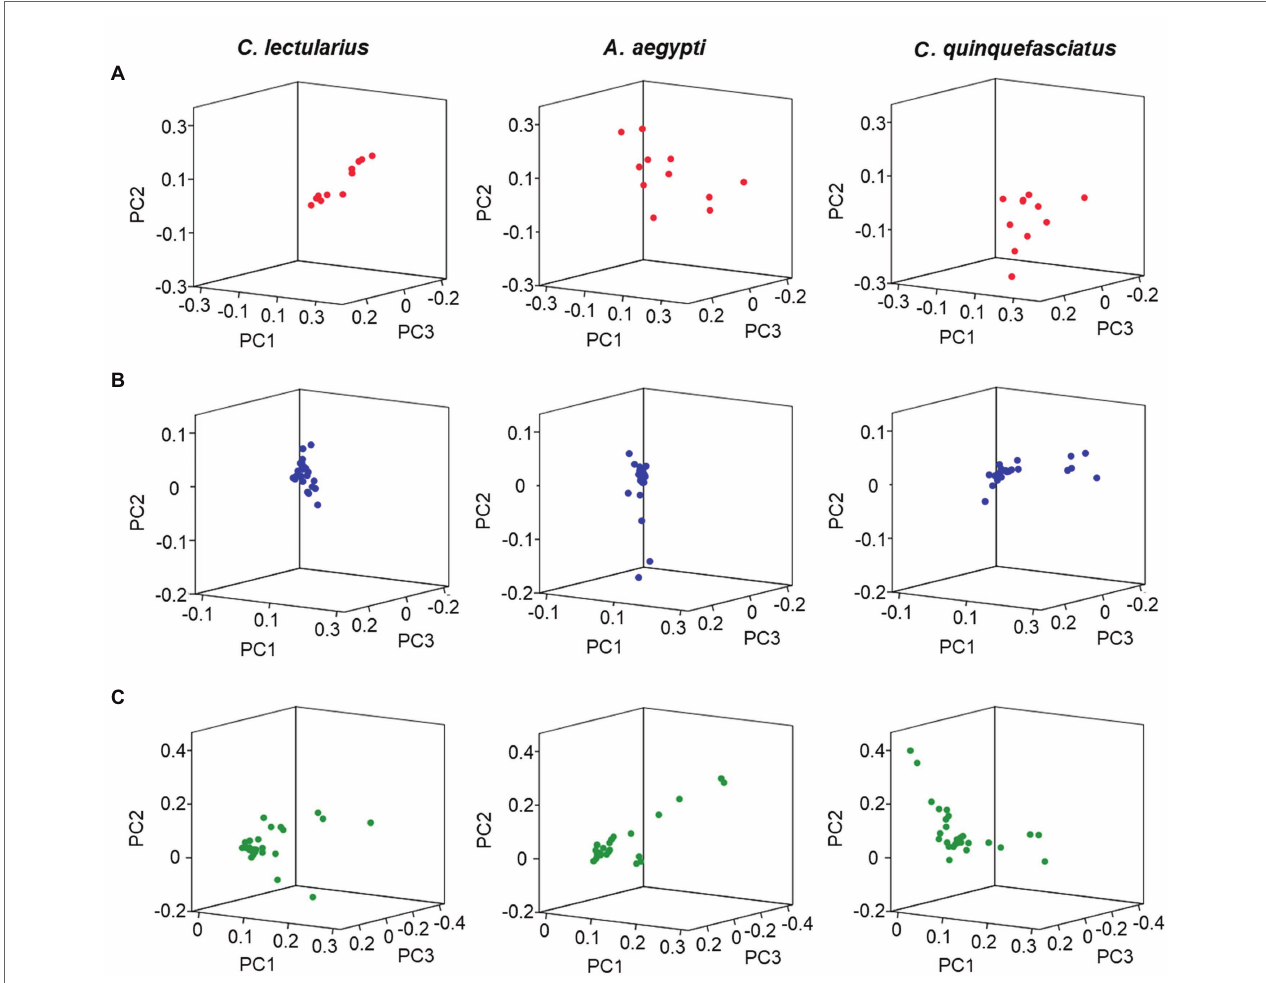
FIGURE 2 | Distribution of odorants in an ORN activity-based odor space. Odor spaces were constructed using the first three principal components of PCA (PAST 3.0, Carey et al., 2010) for the primary sensory responses generated by odorants (Liu et al., 2013, 2014; Liu and Liu, 2015; Ye et al., 2016; Chen et al., 2018, 2019). (A) Aldehydes; (B) aromatics; (C) terpenoids. All odorants from each chemical class are included. The mean inter-odorant distances in three-dimensional space for the set of aldehydes are 0.16 ± 0.01 for C. lectularius , 0.34 ± 0.02 for A. aegypti , and 0.22 ± 0.01 for C. quinquefasciatus ( A. aegypti vs. C. lectularius , p < 0.001; C. quinquefasciatus vs. C. lectularius , p < 0.001, t -test). The mean inter-odorant distances for aromatics are 0.05 ± 0.00 for C. lectularius , 0.10 ± 0.01 for A. aegypti , and 0.10 ± 0.01 for C. quinquefasciatus ( A. aegypti vs. C. lectularius , p < 0.001; C. quinquefasciatus vs. C. lectularius , p < 0.001, t -test). The mean inter-odorant distances for terpenoids are 0.11 ± 0.01 for C. lectularius , 0.14 ± 0.01 for A. aegypti , and 0.16 ± 0.01 for C. quinquefasciatus ( A. aegypti vs. C. lectularius , p < 0.001; C. quinquefasciatus vs. C. lectularius , p < 0.001, t